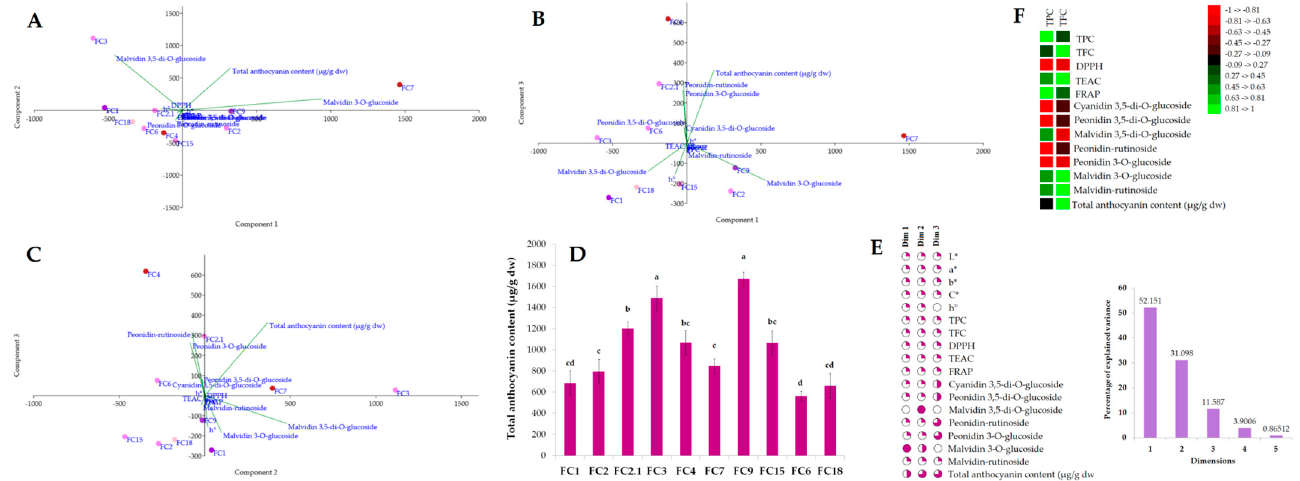
Figure 7. Exploratory multivariate analysis using PCA ( A − C ) with samples distribution into PC1 and PC2, PC1 and PC3, and PC2 and PC3, respectively; ( D ) Total anthocyanins content of Cyclamen genotypes flowers; ( E ) Explained variance by each components and contribution of color measure- ments, antioxidant activities, and anthocyanin profiles to the principal components; ( F ) Pearson’s correlation between total phenolic and flavonoid content, antioxidant activities, and anthocyanin